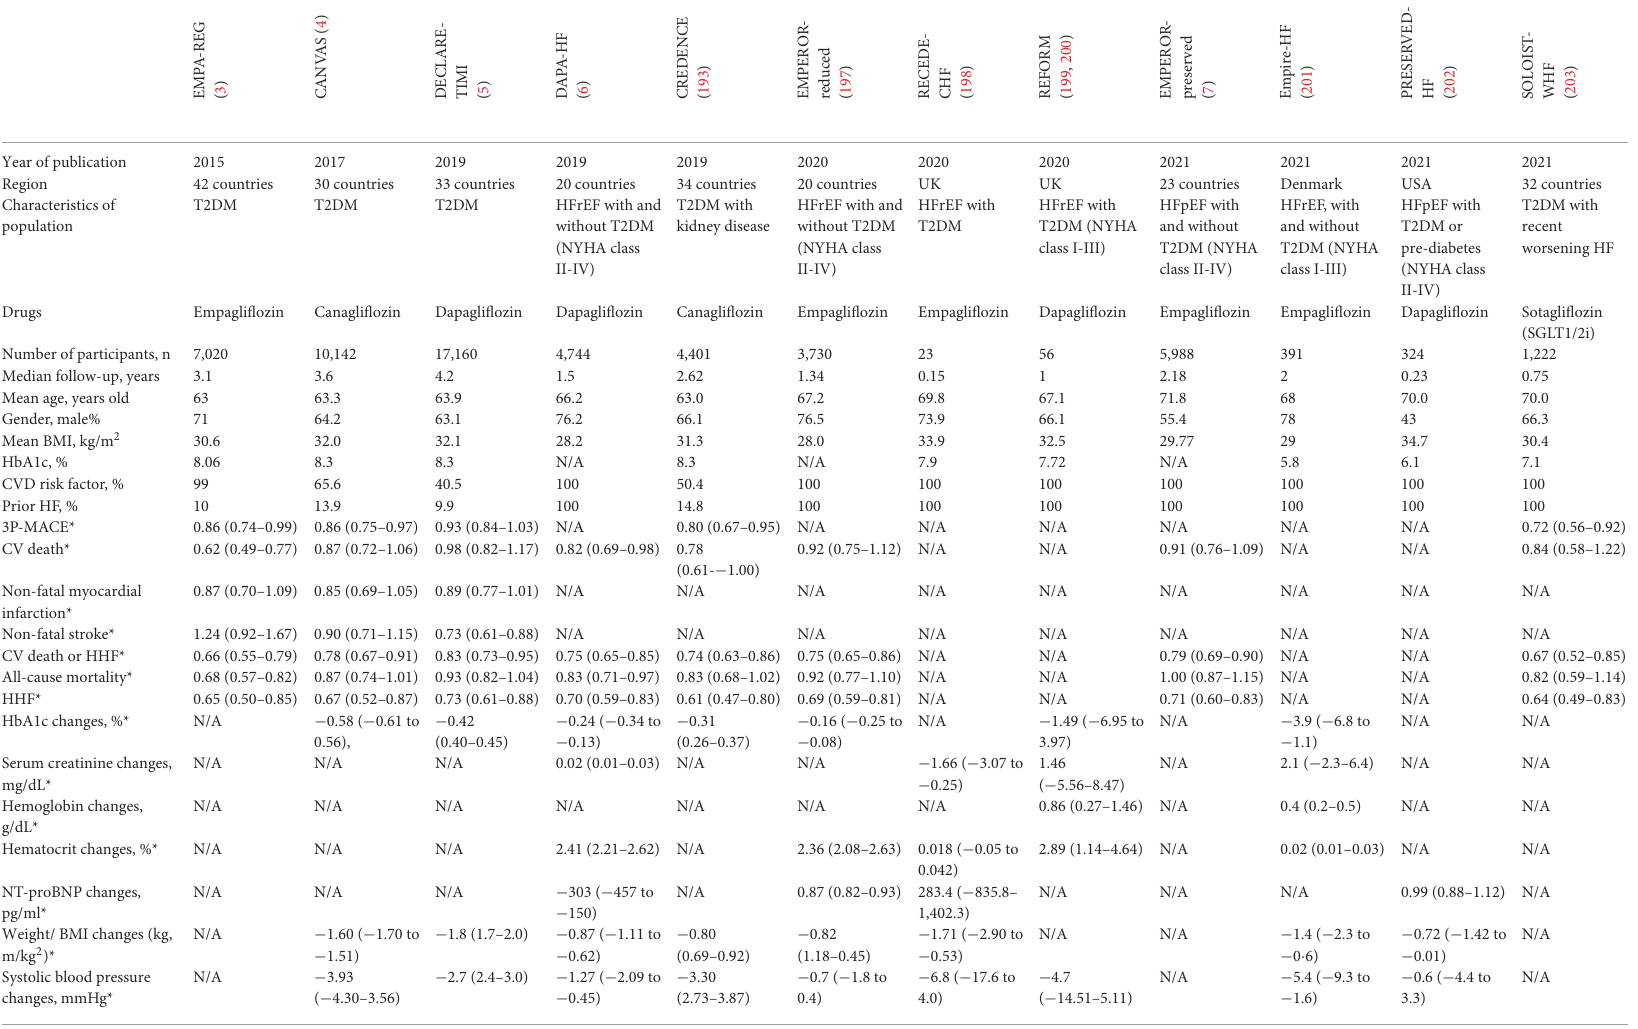
TABLE 1 Contribution of SGLT2i to heart failure in major clinical